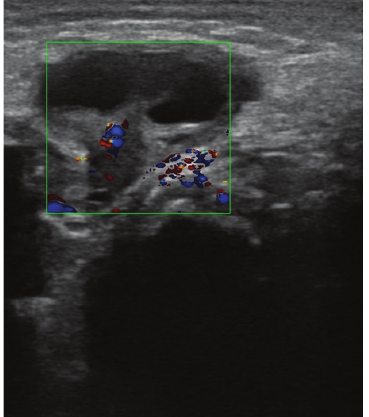
Figure 2: Arterial and venous flows in the right ovary at CDUS (arterial flow coded in red and venous flow in blue colors).